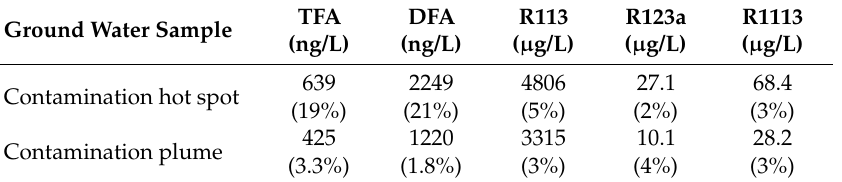
Table 2. Concentration of TFA, DFA, and chlorofluorocarbons (CFCs) in the ground water samples, means and relative standard deviations (TFA and DFA: n = 2; CFCs: n = 6). R113: 1,1,2-trichloro-1,2,2-